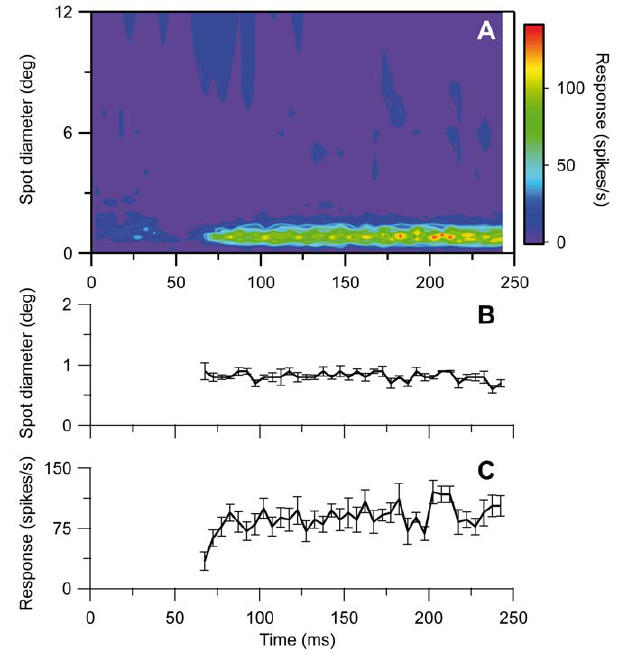
Figure 4. RF dynamics of a lagged on-center X-neuron. Similar plots as for the Y-neuron in Fig. 1. In (A), notice the initial suppression of the response. Number of presentations of each spot 70.